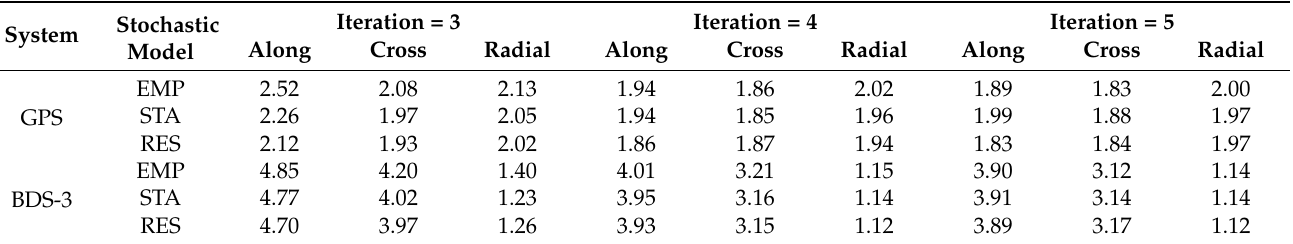
Figure 8. 3D-RMS for GPS satellites orbits estimated with three stochastic models. Table 9. Orbit RMS with three stochastic models in along-track, cross-track, and radial directions (unit: